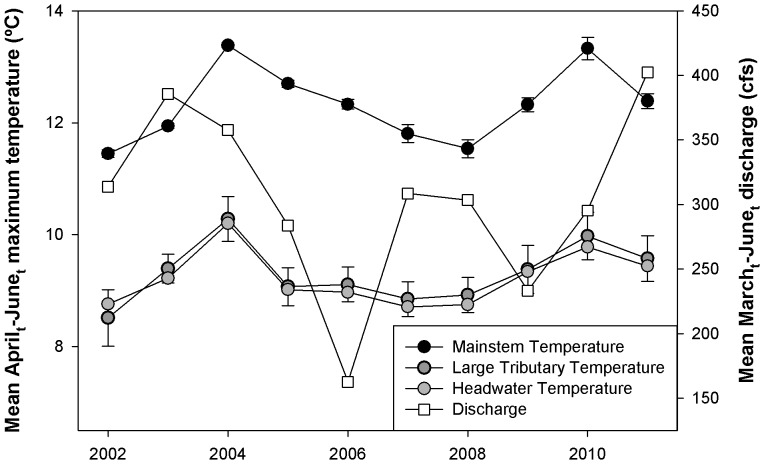
Time series plot of mean temperature and discharge across site types.Time series plots are of year versus mean Aprilt-Junet maximum water temperature and mean Marcht-Junet discharge (Q). Means were for the 2 large tributary sites and the 4 main stem sites.